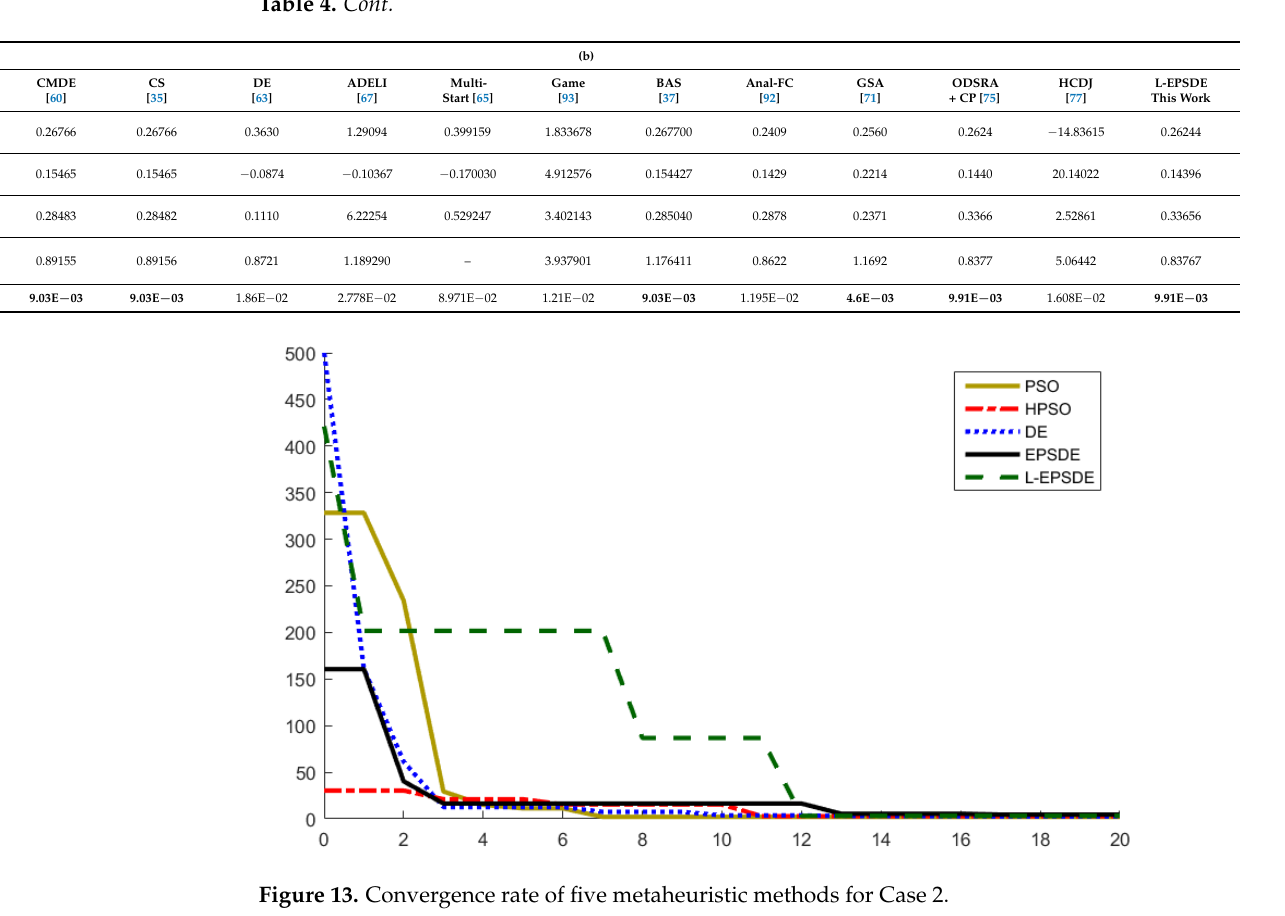
Figure 12. Trajectory of the coupler point of Case 2.